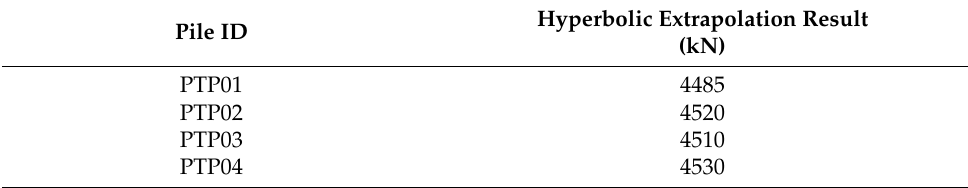
Table 3. Chin hyperbolic extrapolation